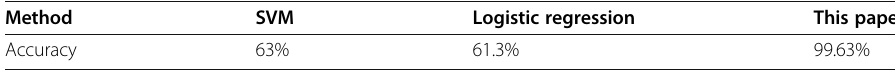
Table 8 The results of the methods